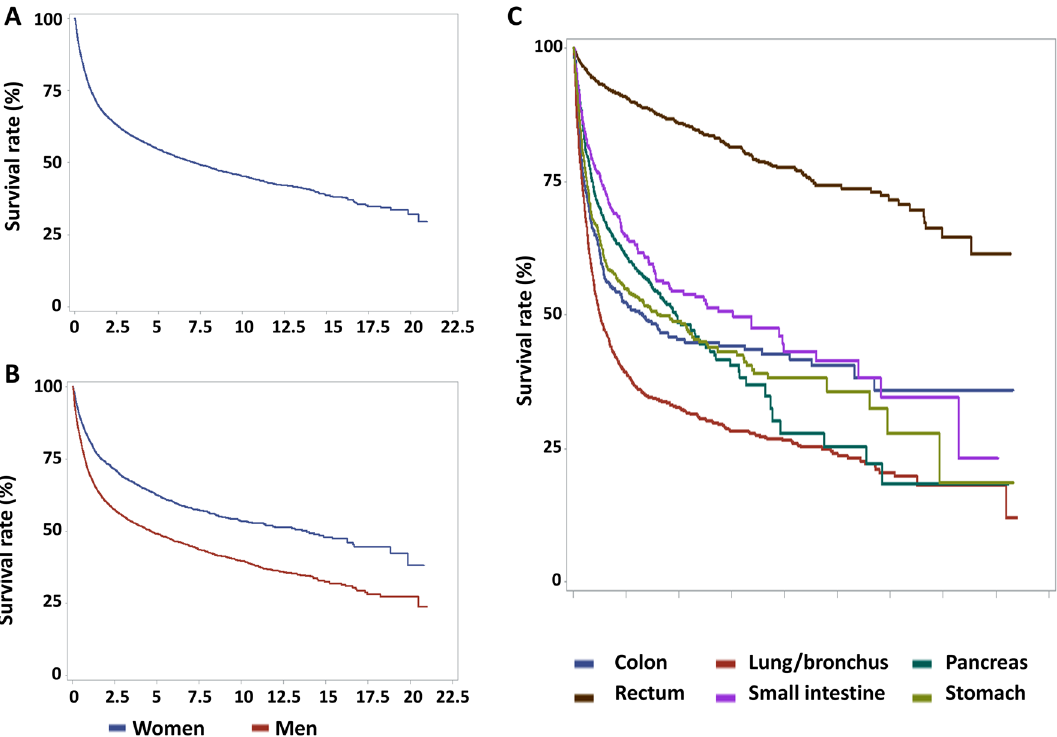
Figure 2. The overall survival of NETs. ( A ) The overall survival of NETs for all patients ( B ) The overall survival of NETs by sex. ( C ) The overall survival of NETs in the 6 most common sites.